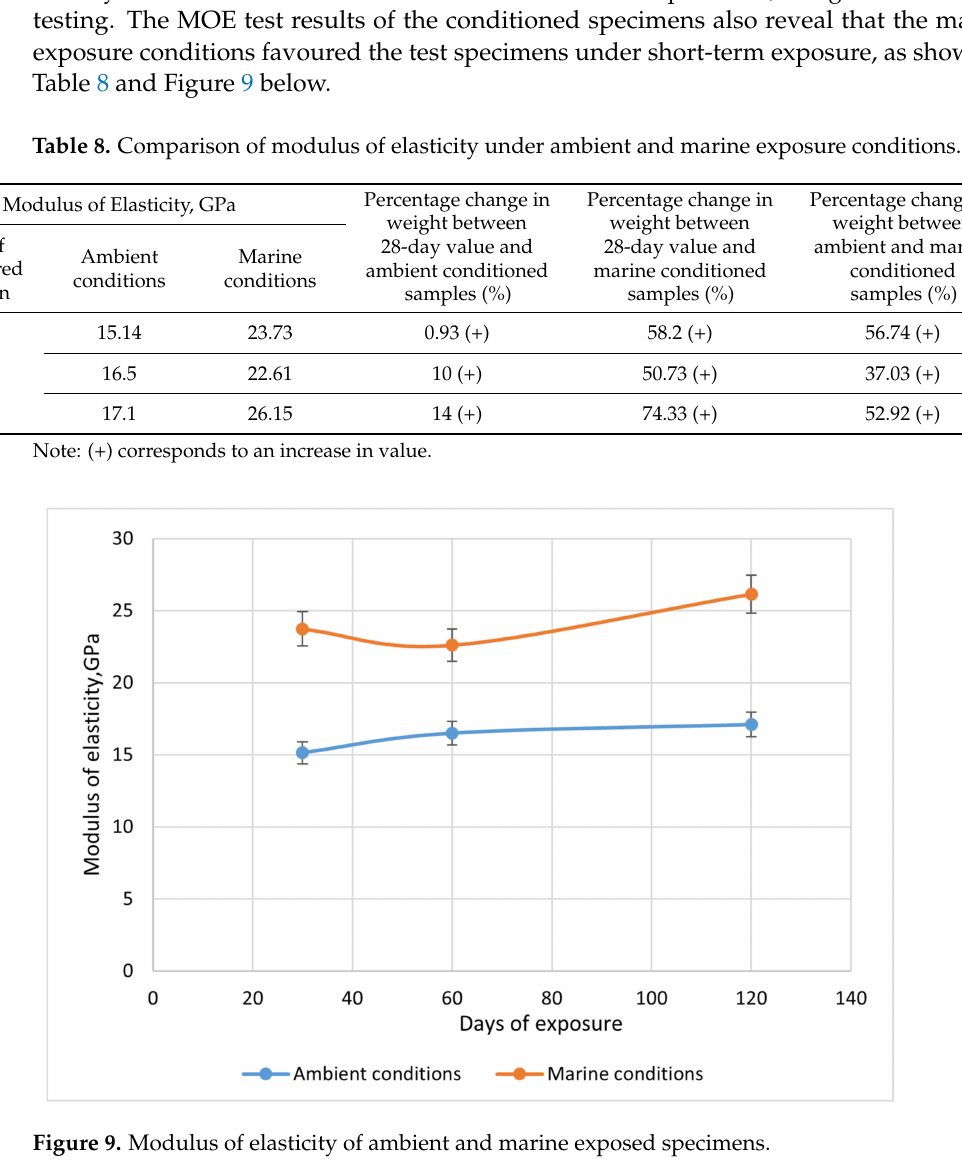
Figure 9. Modulus of elasticity of ambient and marine exposed